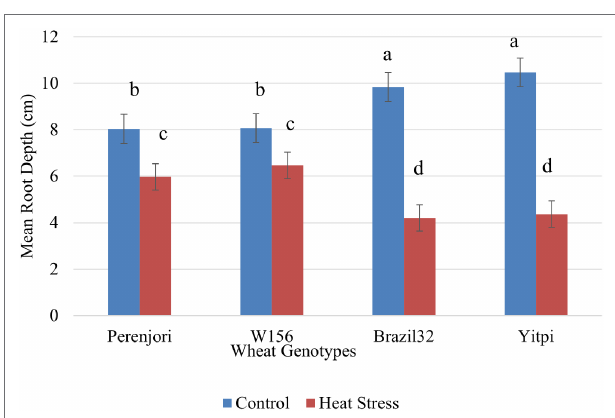
FIGURE 6 | Effect of heat stress on average root depth of wheat genotypes at early seedlings stage. The bar chart shows variation in the mean root depth under control (blue color) and heat stress (orange color) condition, with an error bar on top of each bar. The means denoted by the same letter are not significantly different at p ≤ 0.05 by Tukey–Kramer HSD